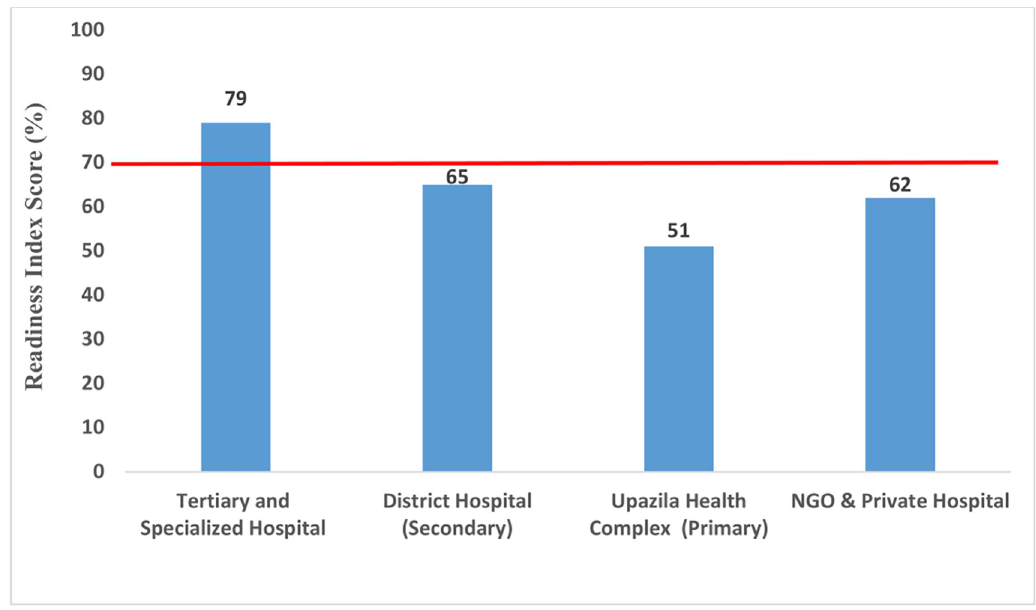
Fig 3. Mean DM service readiness index score for each facility level (the red line indicates the cut off value 70%, above which a facility is considered to be ’ready’ to provide DM services).